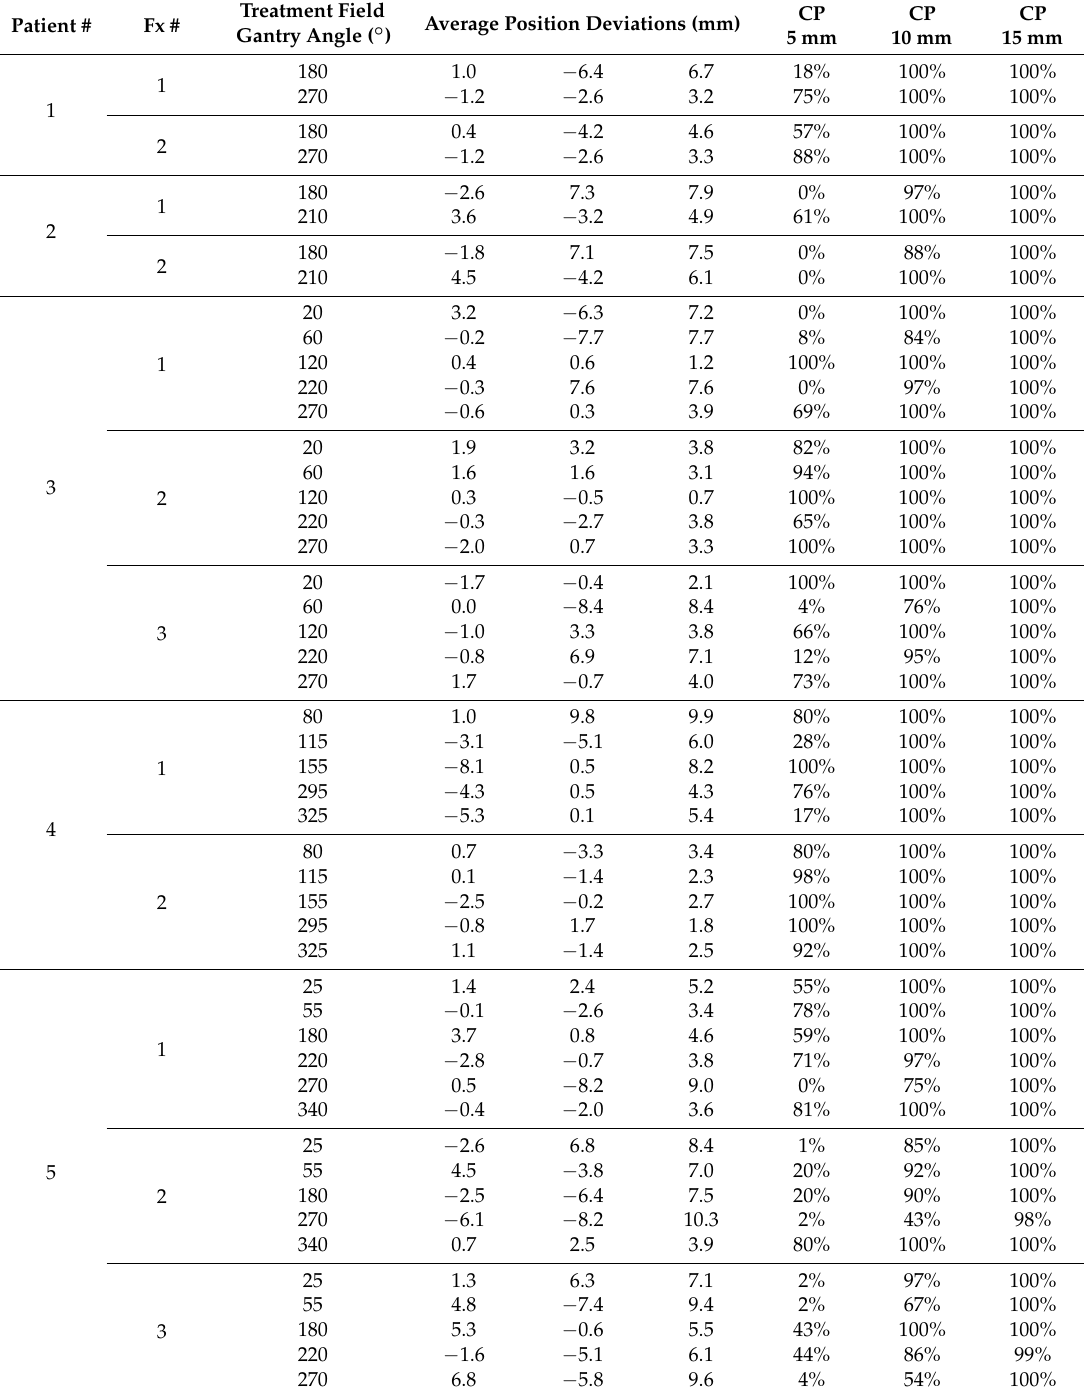
Table A3. Tumor motion results summary. Tumor average position deviations at two dimensions (SI and Orth) and 2D views and cumulated probabilities (CP) within 5 mm, 10 mm, and 15 mm are listed for five patients in every treatment